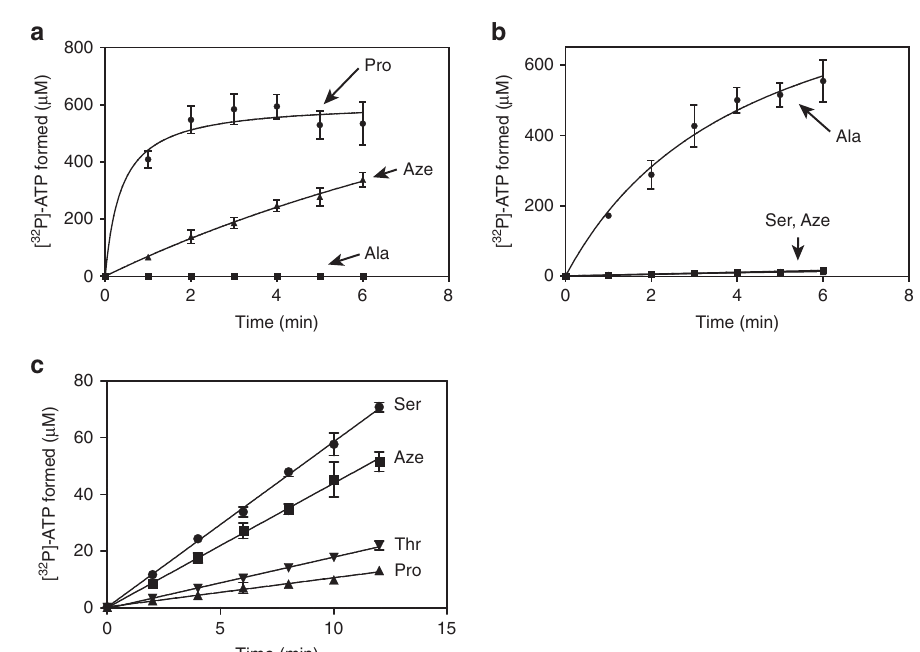
Fig. 4 Activation of Aze by Hs ProRS and Hs AlaRS. a Formation of [ 32 P]-ATP by 0.25 μ M Hs ProRS with either 1 mM Pro, Ala, or Aze. b Formation of [ 32 P]- ATP by 0.25 μ M Hs AlaRS with either 1 mM Ala, Ser, or Aze. c Formation of [ 32 P]-ATP by 0.5 µ M H s AlaRS with either 1 mM Ser, Aze, Thr, or Pro. (Error bars represent s.d.)